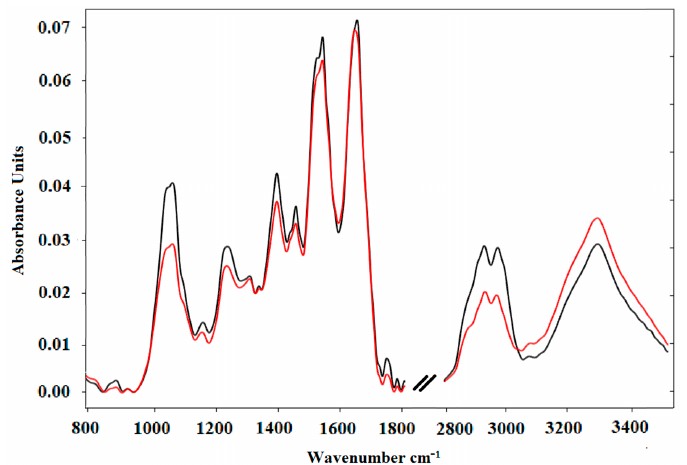
Figure 1. Normalized average FTIR spectra of serum samples: control (black) and Acute Lymphoblastic Leukemia Precursor B (red). Spectra cover the range of 800–3500 cm − 1 . Table 1. FTIR peaks position with corresponding vibrations in the analyzed three groups. FTIR Spectroscopy Peaks Control Sample